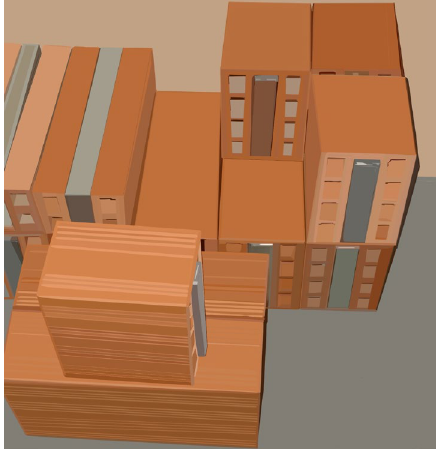
Figure 1. Building material with micron-sized capsules [5].